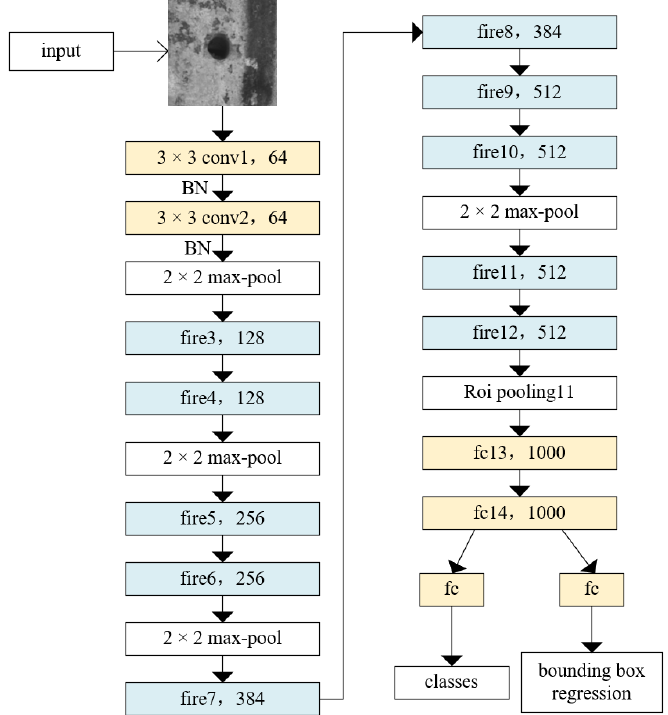
Figure 5. Optimization of SqueezeNet network structure.